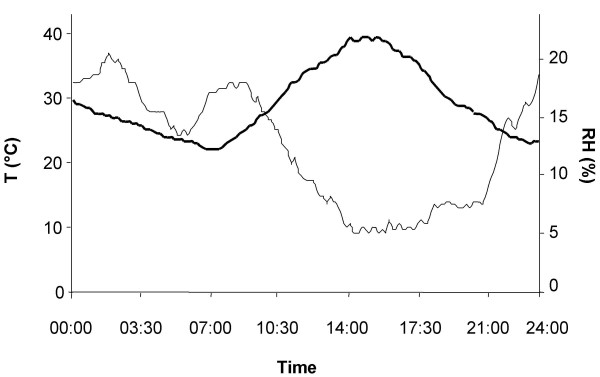
Typical temperature (bold line) and relative humidity patterns in the field cage in April logged at 1 m height in section C over 24 hrs. The increase in humidity in the morning is associated with the flooding of the plant beds.